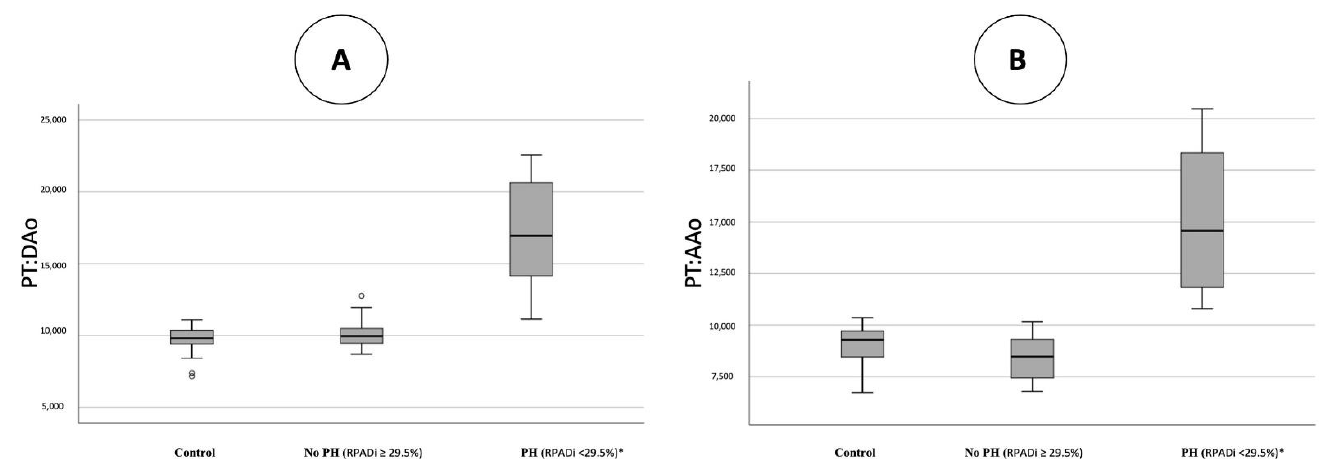
Figure 2. Scatterplots illustrating pulmonary trunk to descending aorta ratio (PT:DAo) ( A ) and pulmonary trunk to ascending aorta ratio (PT:AAo) ( B ), obtained in healthy dogs (control), in dogs with heartworm and no presence/mild pulmonary hypertension (RPADi ≥ 29.5%), and dogs with heartworm and moderate to severe pulmonary hypertension (RPADi < 29.5%). The box plots represent median (solid horizontal lines within boxes), 25th, and 75th percentiles (boxes) and minimum and maximum values (whiskers). Statistically significant differences (*) were observed between control and RPADi ≥ 29.5% dogs when compared to RPADi < 29.5% dogs. Table 2. Results of simple regression analyses for the prediction of RPAD index.